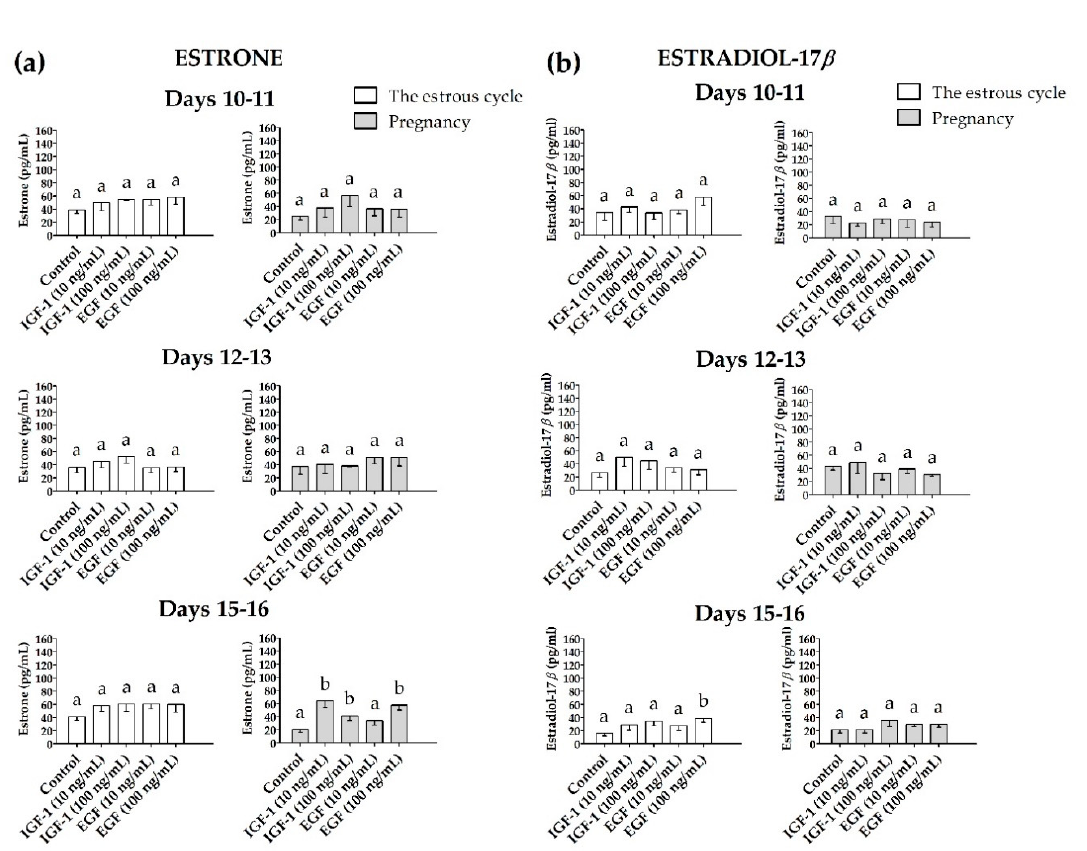
Figure 7. The concentration of ( a ) estrone and ( b ) estradiol-17 β in media collected after in vitro incubation of myometrial slices treated with IGF-1 (10 and 100 ng/mL) or EGF (10 and 100 ng/mL, one-way ANOVA, Dunnett’s post hoc test). Statistically significant differences were considered at p ≤ 0.05 and indicated as lower-case letters (a,b) above the bars.